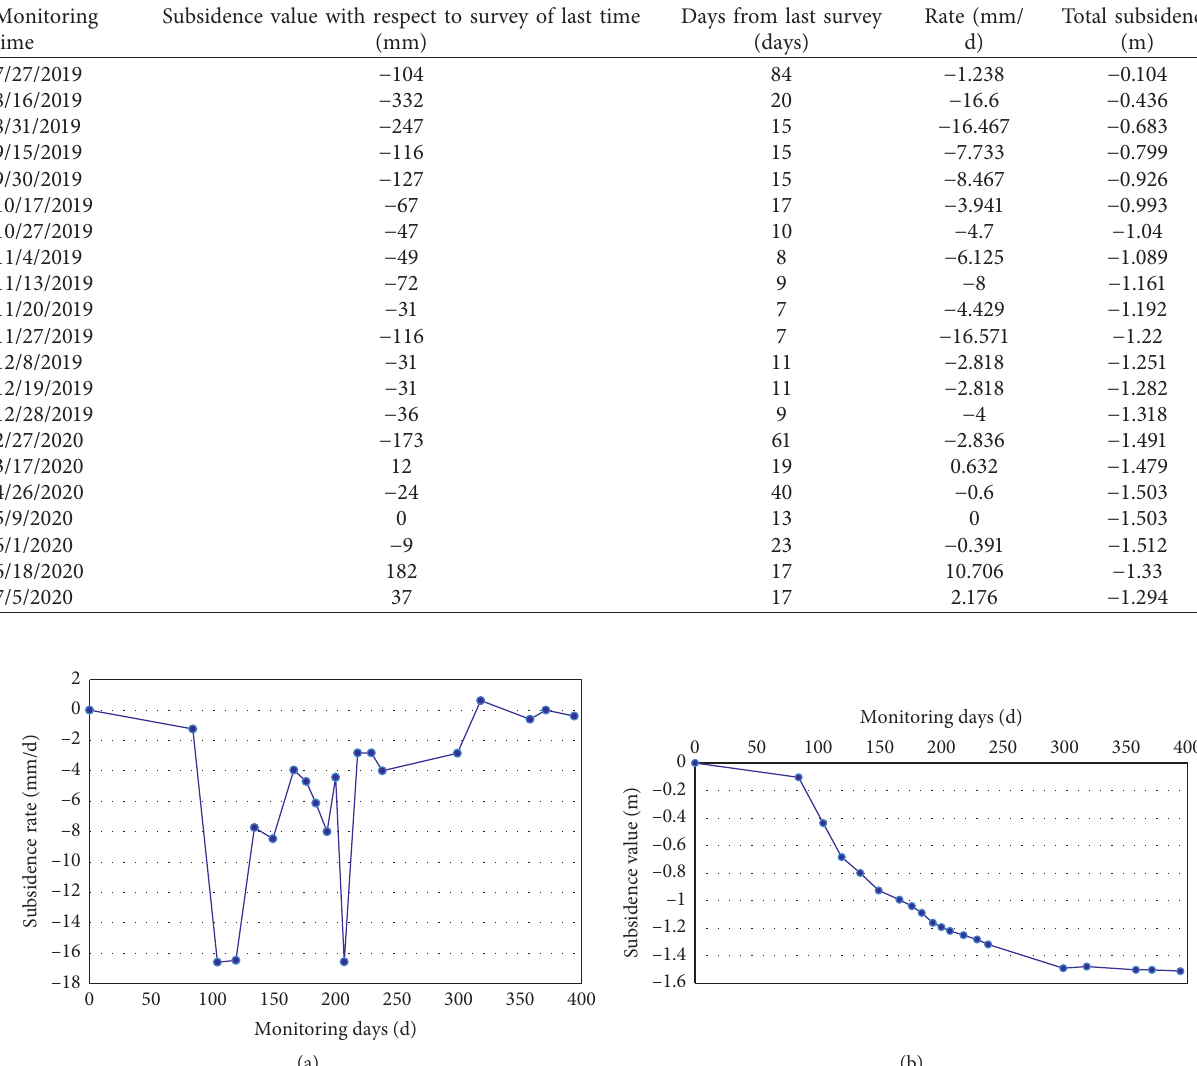
Figure 10: Profile of data of 4/1/2020 of 31103 panel and a fit curve to it. Table 5: Subsidence rate of point A43.